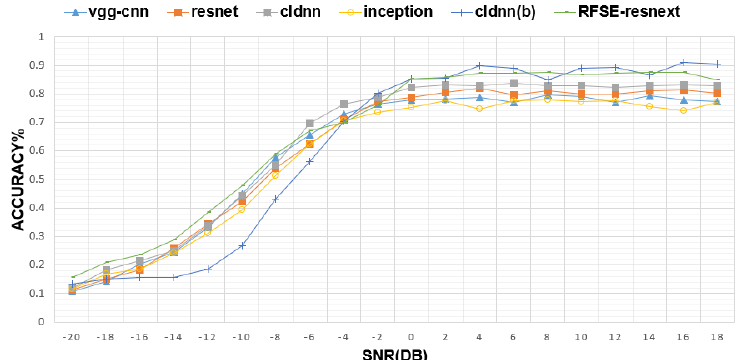
Figure 9. Comparison of the recognition performance of six models